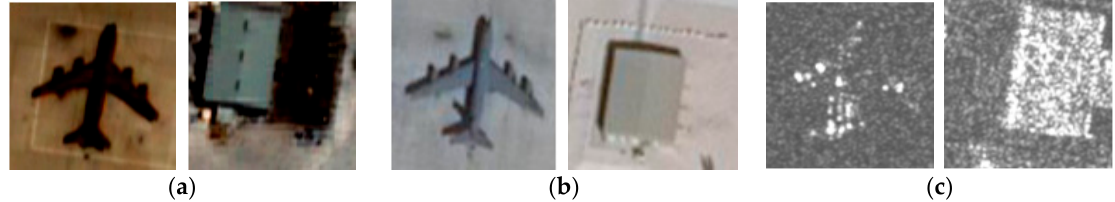
Figure 4. Target and background slices in multiple sources. ( a ) Optical set A in Google Earth; ( b ) optical set B in Quickbird; ( c ) SAR in Terra_SAR.